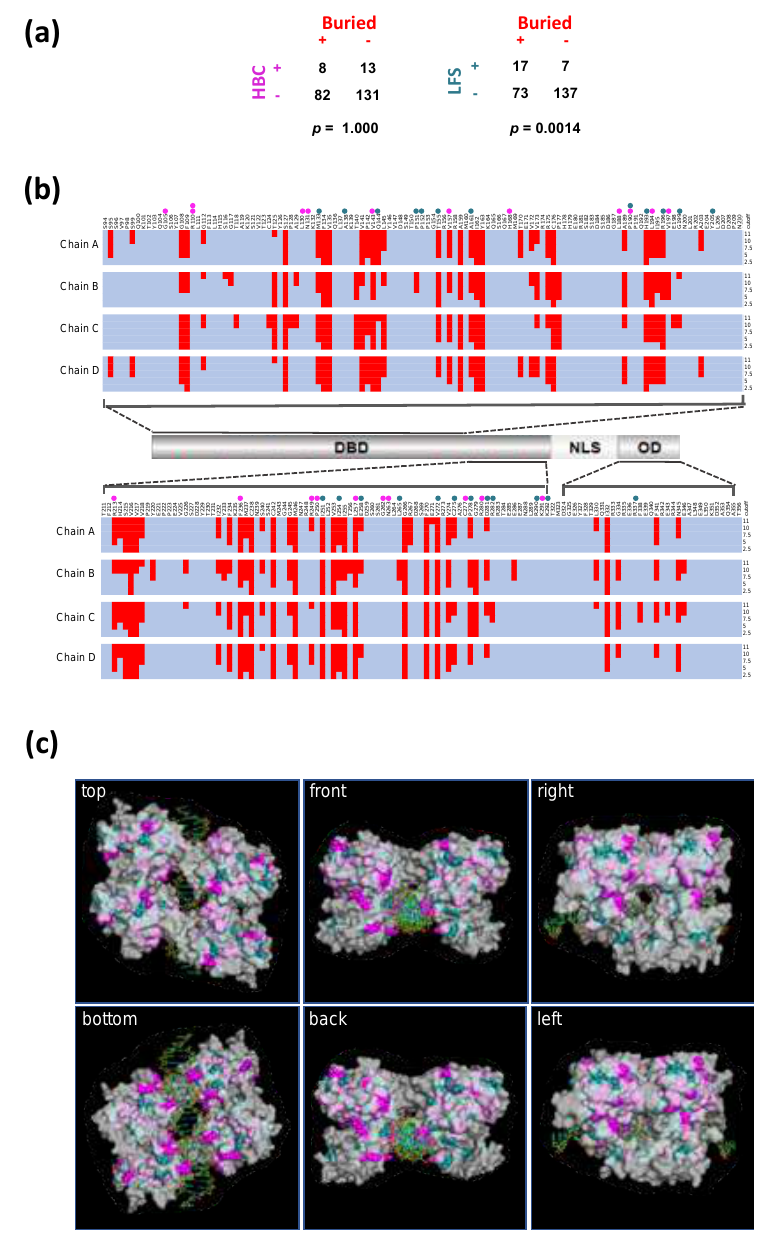
Figure 2. Comparison of surface exposure of TP53 missense variants in LFS and HBC. ( a ) LFS-residues are significantly enriched in Buried residues with lower surface exposure (<cutoff at 11Å 2 ) than expected by chance while HBC-residues are not. Contingency tables and respective p -values are shown (Fisher’s Exact Test, two-sided). Residues were defined as Buried if their surface area was below the cutoff value in any of the 4 TP53 monomers in the TP53 structure (PDB name = 3TS8). The HBC-residues R379 and E388 are not included in this TP53 structure, and the R110 was calculated once, therefore only 21 HBC-residues were included. ( b ) Location of Buried residues (red shading) in a TP53 derivative containing the DBD and OD that was used for tertiary structure determination (3TS8). Cutoff values (Å 2 ) to distinguish between Surface (>cutoff) and Buried residues (<cutoff) were 11 (used in the statistical test in ( a ), 10, 7.5, 5 and 2.5 (see right side of panel). Results are shown for each of the monomers (Chains A–D) within the TP53 tetramer bound to DNA. LFS-residues and HBC-residues are indicated by cyan and magenta filled circles respectively. ( c ) Localization of LFS-residues (cyan) and HBC-residues (magenta) in relation to the surface of the TP53 tetramer bound to DNA (3TS8, transparent grey). Stronger color indicates Surface exposure while weaker color indicates parts of residues that are below the protein surface (Buried). The 6 panels show all views of the protein caused by stepwise 90 ◦ rotations of the “top”